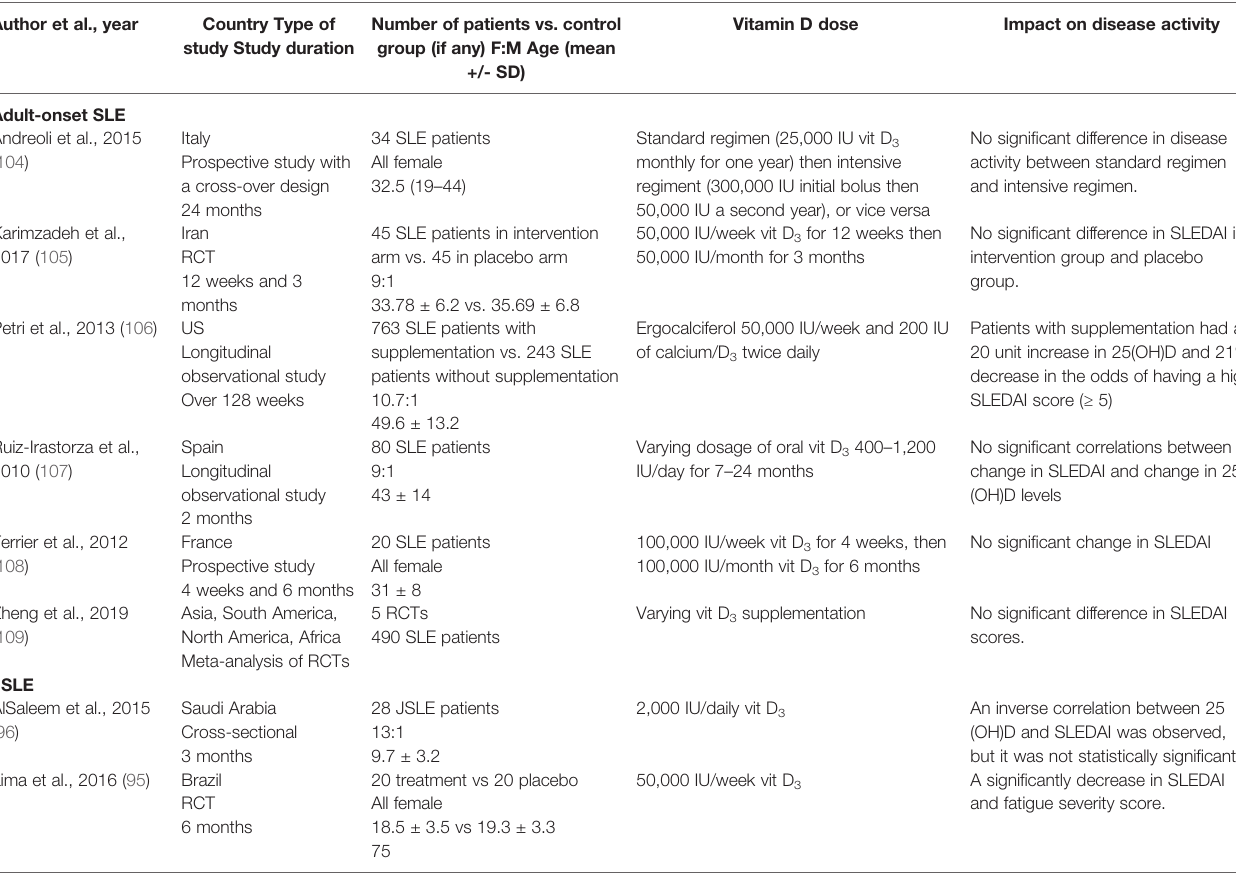
TABLE 5 | Impact of vitamin D supplementation on JSLE and adult-onset SLE